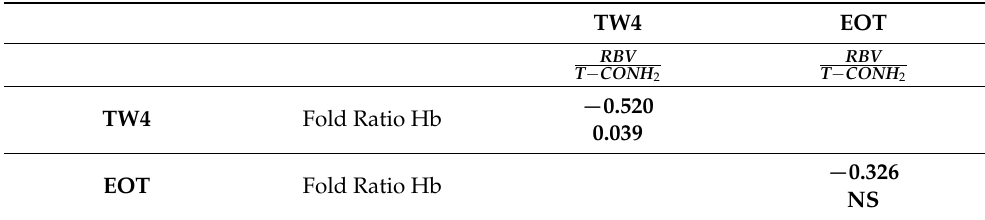
Table 2. Pearson correlation values with the corresponding p value for TW4 and EOT patients ( n = 16). Fold ratio of Hb was determined with respect to the baseline.